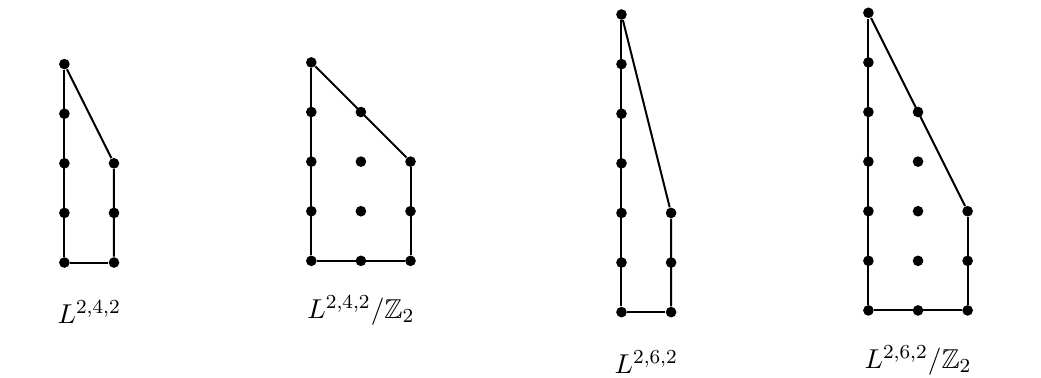
Figure 1. Examples of chiral orbifolds for the L a,b,a